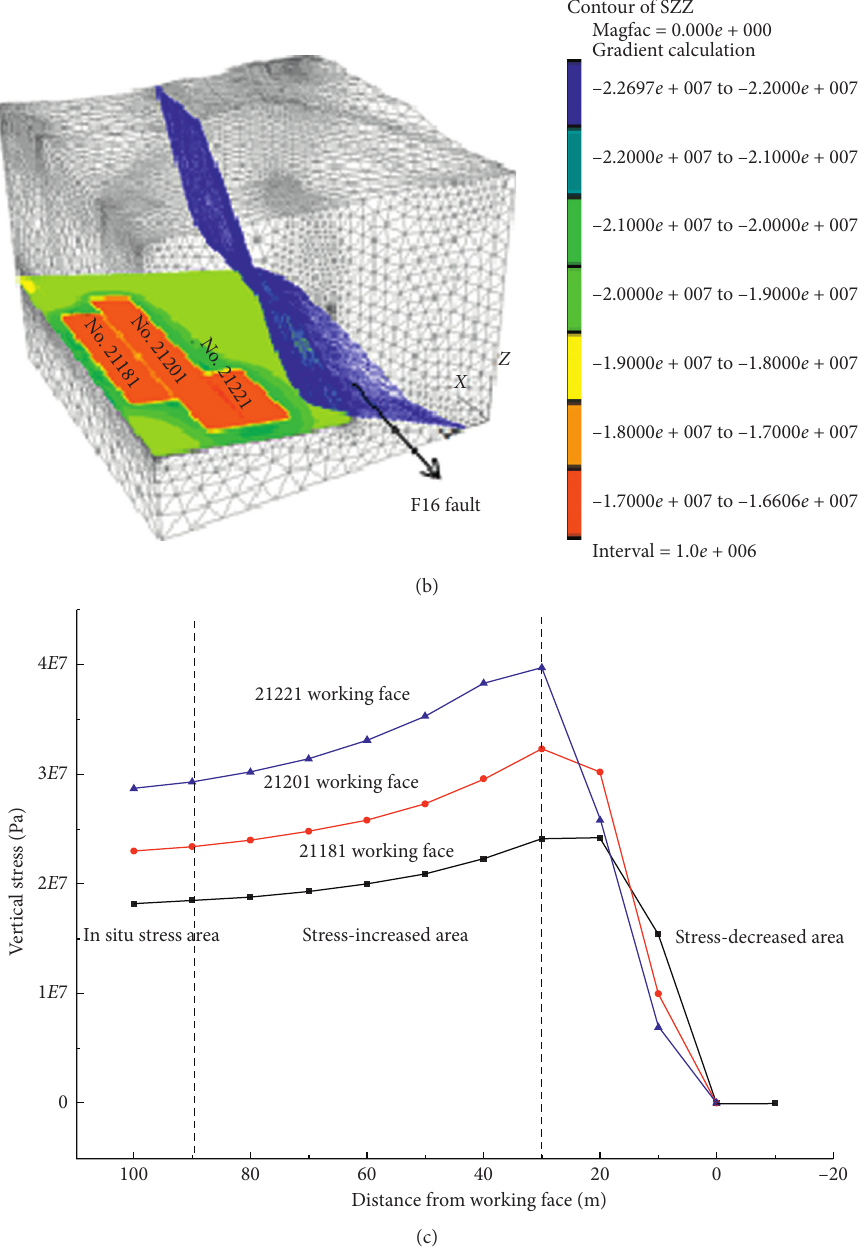
Figure 12: Variation of vertical stress in coal seam. (a) Vertical stress before mining, (b) vertical stress during mining, and (c) stress variation curves in each working